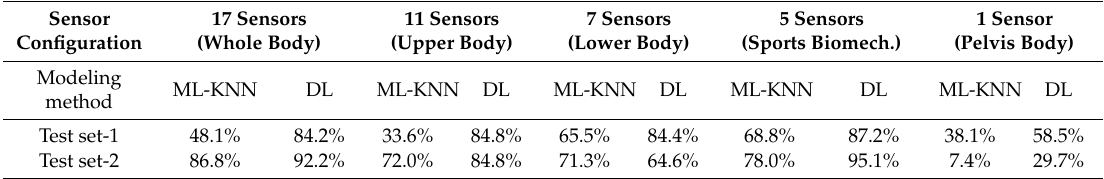
Figure 4. Comparison between the machine learning (KNN) and deep learning methods on classification accuracies for the validation dataset for the five different sensor configurations. Table 22. Comparison between the machine learning (ML-KNN) and deep learning (DL) methods on classification accuracies for test set-1 and test set-2 for the five different sensor